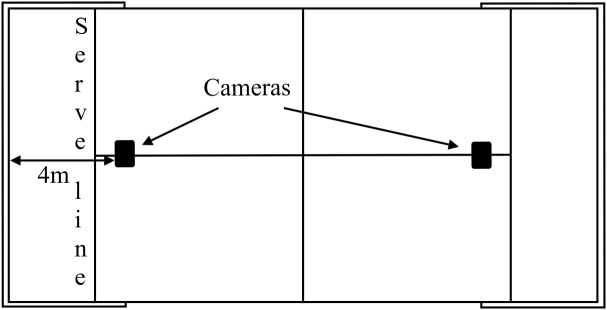
Placement of the cameras at the ceiling above the court.